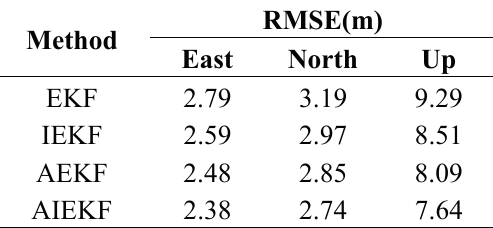
Table 3. RMSE of static positioning test depending on scalar, EKF, IEKF and AIEKF